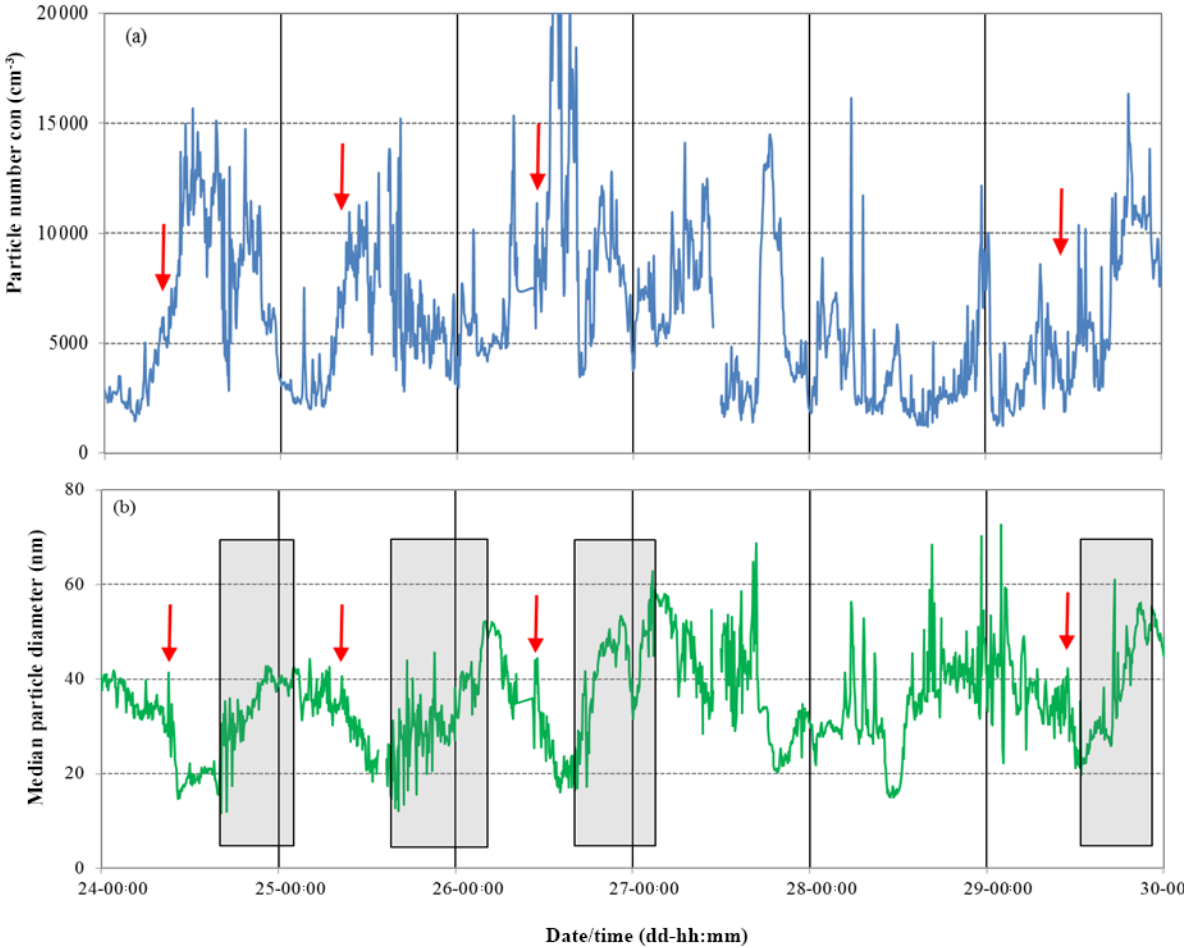
Figure 4. (a) the total PNC and (b) median particle diameter from the SMPS during 24–30 July 2012. Red arrows and gray boxes represent the day time NPF events and the growth events,